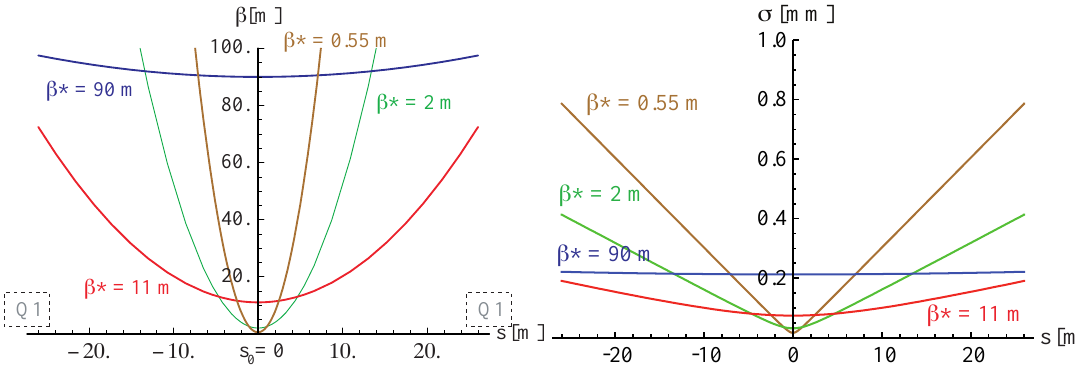
Figure 1. β -functions and beam sizes σ at distance s from the interaction point at s 0 = 0, for β ∗ = 0.55, 2, 11 and 90m up to L ∗ = ± 26m, for the LHC design beam energy E b = 7TeV and normalized emittance (cid:101) N = 3.75 µ